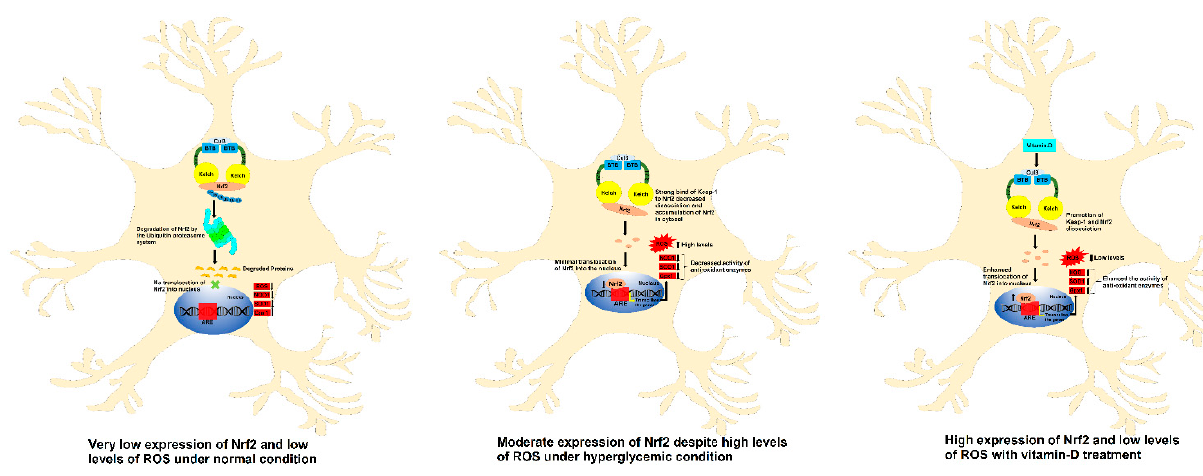
Figure 8. Effect of vitamin-D on the Nrf2 and antioxidants enzyme in SKNSH cell line. Under normoxic conditions, Keap1 inactivates Nrf2 by binding [49]. Therefore, we have tested whether vitamin D inhibits the binding of Keap-1 to Nrf2 using in silico docking approach. Experimentally, vitamin D3 was evaluated for its binding affinity towards Keap-1 (4IQK) and the results represented in Table 2. Vitamin D exhibited the highest binding affinity with a docking score of − 56.45 towards 4IQK. The known acti- vators of Nrf2 viz., Sulforaphane, Pterostilbene and Bardoxolone showed a docking score of − 24.82, − 37.79 and − 16.79 towards Keap-1(4IQK) respectively. Based on these observa- tions, we hypothesize that vitamin D-mediated activation of Nrf2 is likely due to its strong binding strength to the Keap-1 [50]. Analysis of the best docking poses showed the most interacting residues in the ac- tive sites of Keap-1 and cholecalciferol are shown in Figure 9 and Table 2. Further analy- sis of the interactions between cholecalciferol and Keap-1 revealed that the H atom (polar H interaction) of ligands were bound via carbon hydrogen bond to Arg380 with the contact distance of 2.73 Å whereas the aromatic and benzene rings were attached via al- kyl (hydrophobic interaction) to Ala556, Tyr525 and Tyr572 with the contact distance of 3.57 & 5.30, 4.17 & 5.19 and 4.47 Å, respectively. Cholecalciferol and its interactions with Keap-1 in 3D and 2D poses are shown in Figure 9A,B. Interactions of other molecules with Keap-1 are represented in Supplemental Figure S4. Table 2. Docking score, nature of interaction(s), and the key amino acids involved in binding of selected Nrf2 activators. Selected Biomolecules